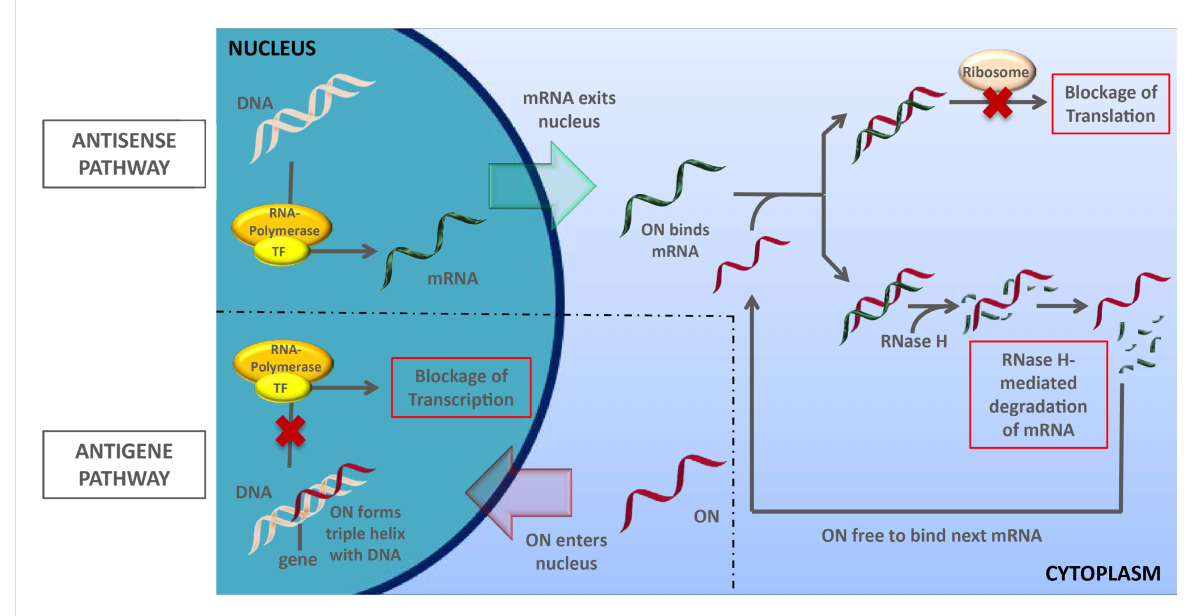
Figure 1: Biological action of single-stranded oligonucleotides (ON): antigene and antisense pathways.